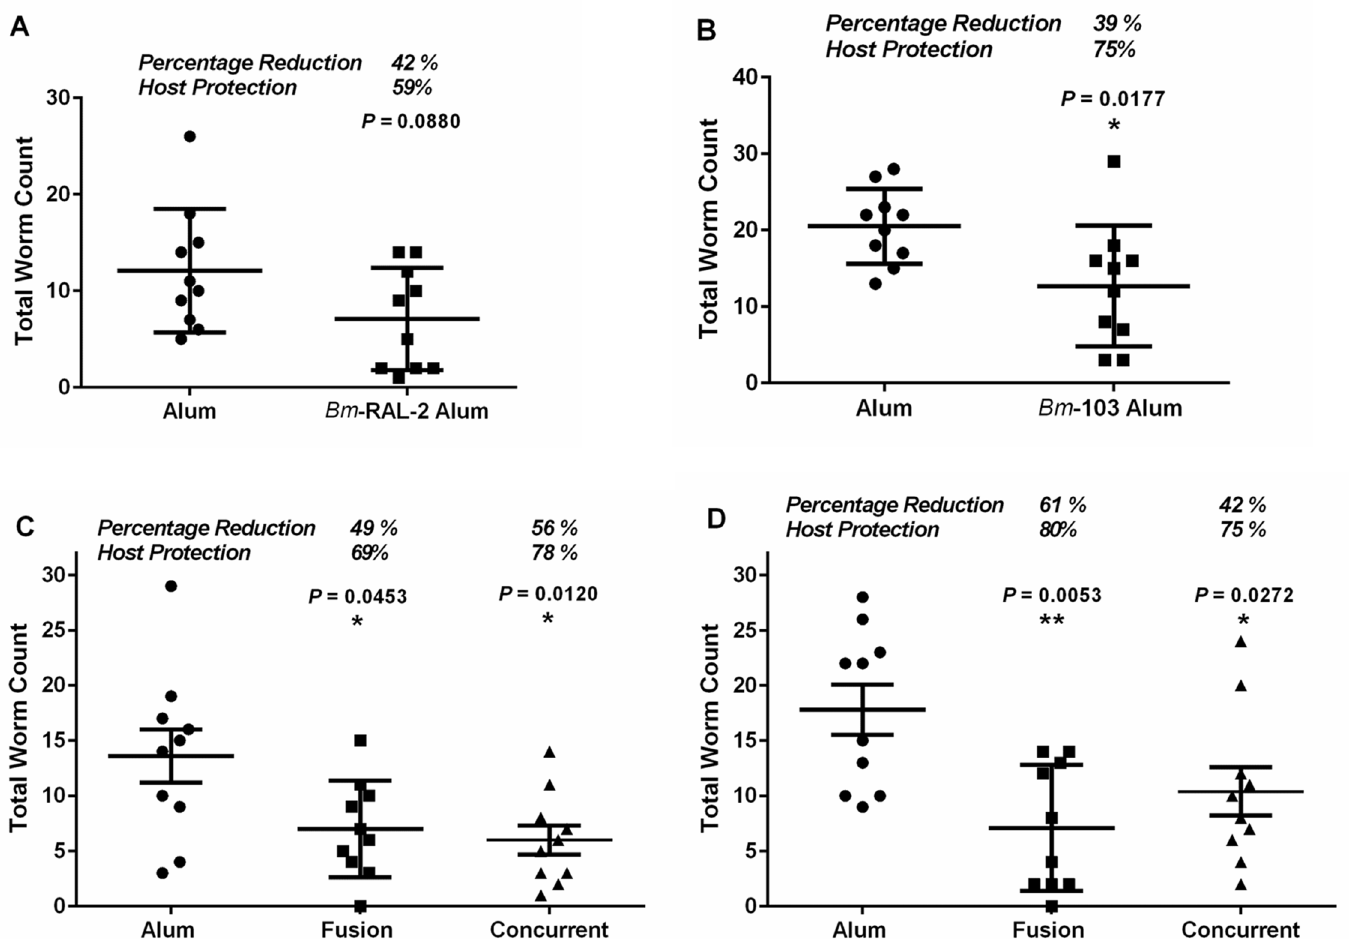
Fig 2. Effect of vaccination with Bm -RAL-2 and Bm -103 individually, concurrently and as a fusion protein on the development of protective immunity manifested as % reduction in worm burdens and % host protection against infection with Brugia malayi L3s in Mongolian gerbils. (A) Vaccination with Bm -RAL-2 (42 dpi); (B) Vaccination with Bm -103 (42 dpi); (C) Vaccination with Bm -RAL-2 — Bm -103 fusion protein or with Bm -RAL-2 + Bm - 103 concurrently (90 dpi); (D) Vaccination with Bm -RAL-2 — Bm -103 fusion protein or Bm -RAL-2 + Bm -103 concurrently (150 dpi). Each dot represents the total number of adult worms recovered from an individual animal. The lines represent mean with standard deviation. P (cid:1) 0.05 denotes a statistically significant difference in total worm recovery (percent reduction) between vaccinated and alum control group, Mann – Whitney U Test, GraphPad Prism 6.